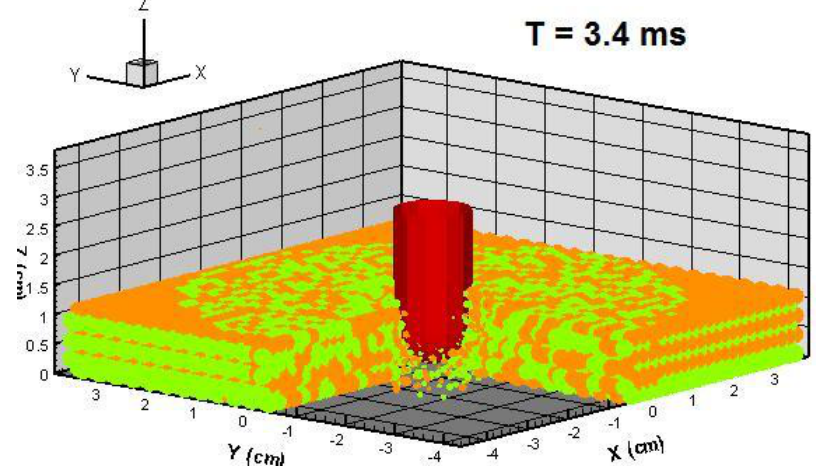
Figure 14. Snapshot of HLPM prediction of fracture of punch-shear of vinyl ester at T = 3.4 ms. Maximum drop velocity of indenter is 3.55